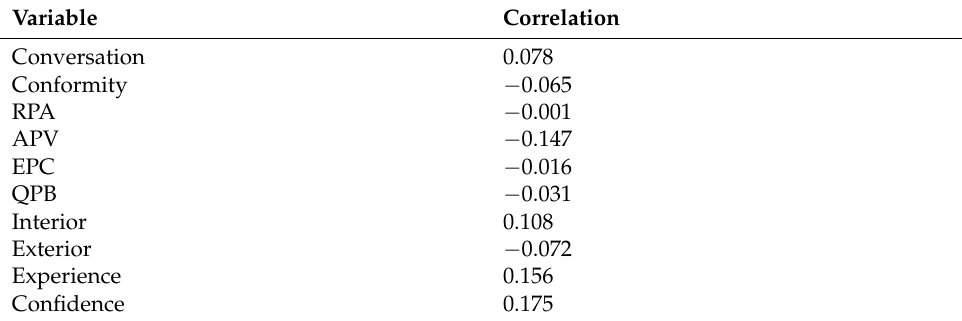
Table 6. Correlations with financial